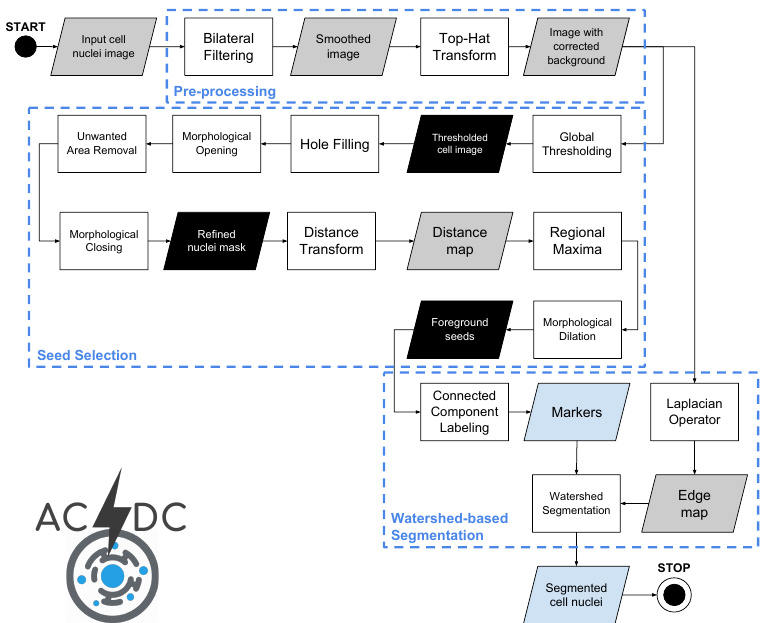
Figure 4. Flow diagram of the ACDC pipeline. The gray, black and light-blue data blocks denote gray-scale images, binary masks and information extracted from the images, respectively. The three macro-blocks represent the three main processing phases, namely: pre-processing, seed selection, and watershed-based